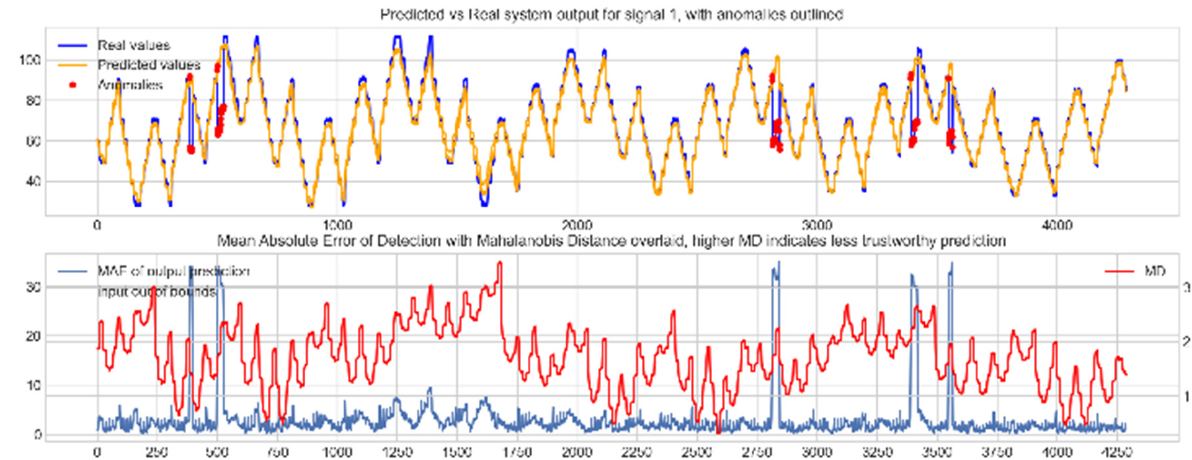
Figure 6. Predicted vs. Real NN prediction for output signal 1, the right elevon.